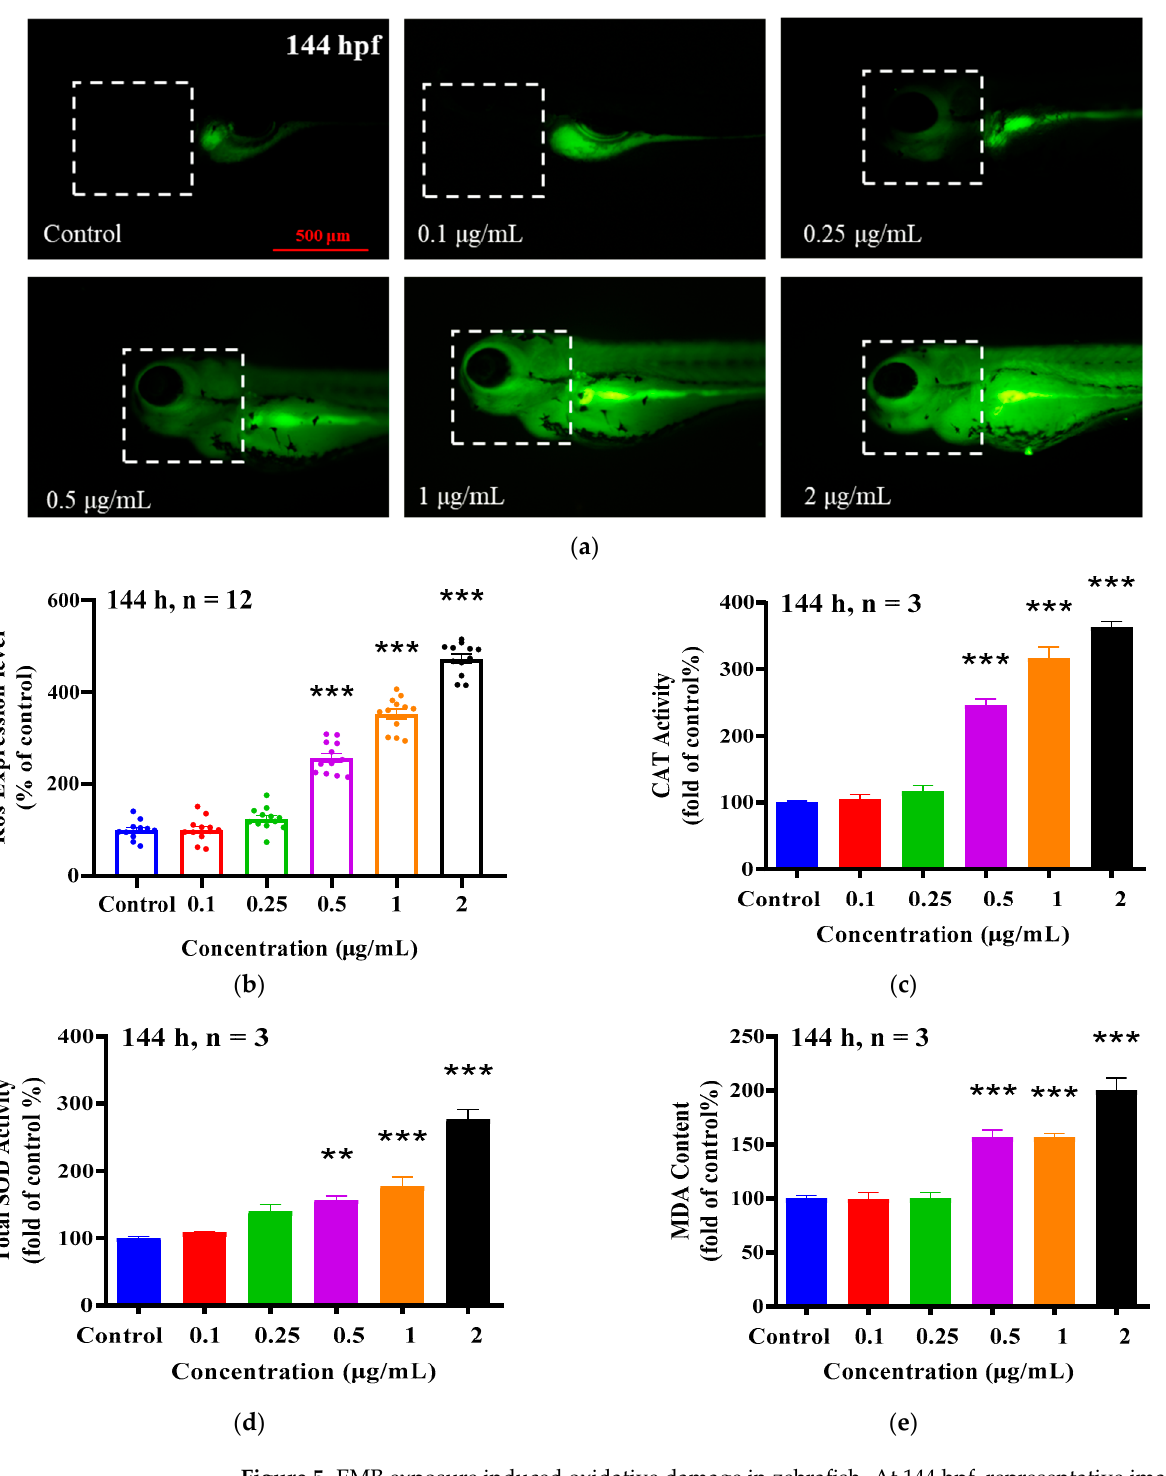
Figure 5. EMB exposure induced oxidative damage in zebrafish. At 144 hpf, representative images of reactive oxygen species in the head of zebrafish larvae ( a ), fluorescence statistics ( b ), CAT enzyme activity ( c ), SOD enzyme activity ( d ), and MDA content ( e ), (20 larvae pooled as one sample, n = 3). ** p < 0.01, *** p < 0.001, compared with control